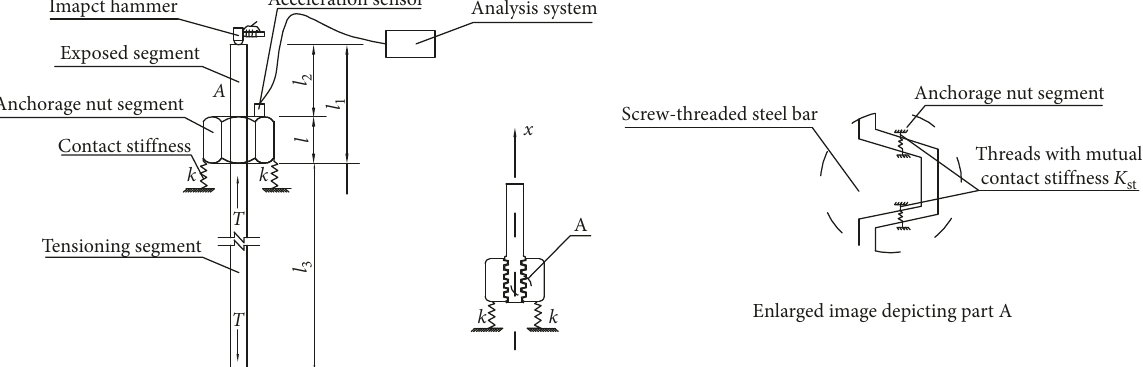
Figure 2: Mechanical vibration model of the vertical P/S